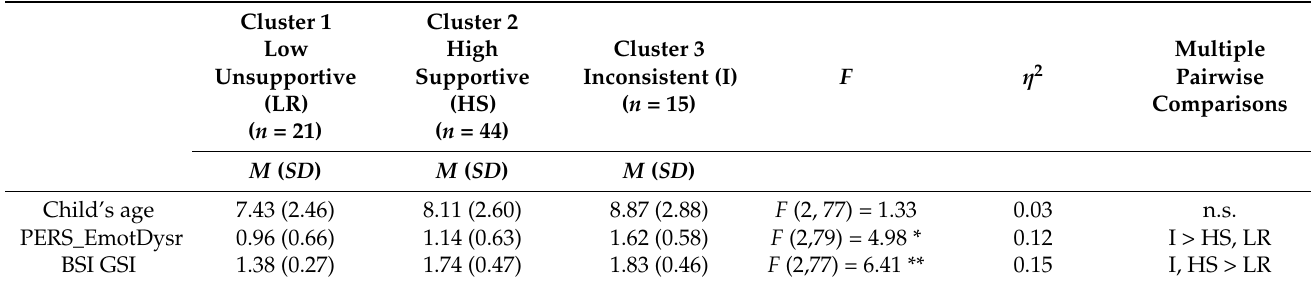
Table 3. Comparisons between parents’ clusters in relation to parents’ emotion dysregulation, psychopathological symptoms, and child’s age: means ( M ), standard deviations ( SD ), ANOVAs results, and multiple pairwise comparisons.